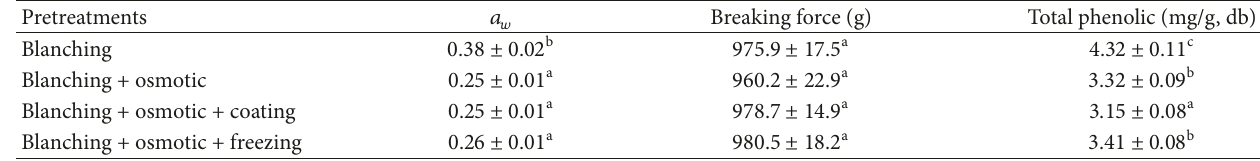
Table 2: Effects of pretreatments on 𝑎 𝑤 , breaking force, and total phenolic content of shiitake mushroom chips.